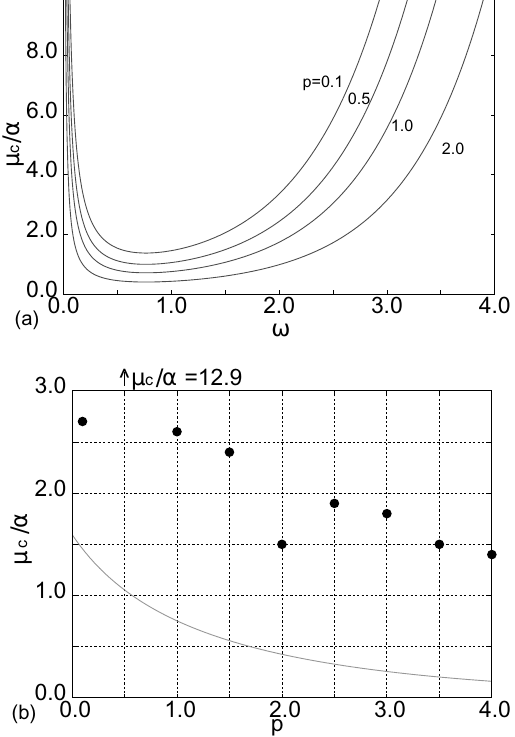
Fig. 3. Critical value of excitation µ c versus ω (Fig. 3(a)) and exponent p (Fig. 3(b)) for δ = − 1 , γ = 1 . Points in Fig. 3(b) show numerical results of transitions to chaos obtained by Lyapunov exponents. At the saddle point x = 0 , for an unperturbed system (Fig. 1(a)), the system velocity reaches zero, (for